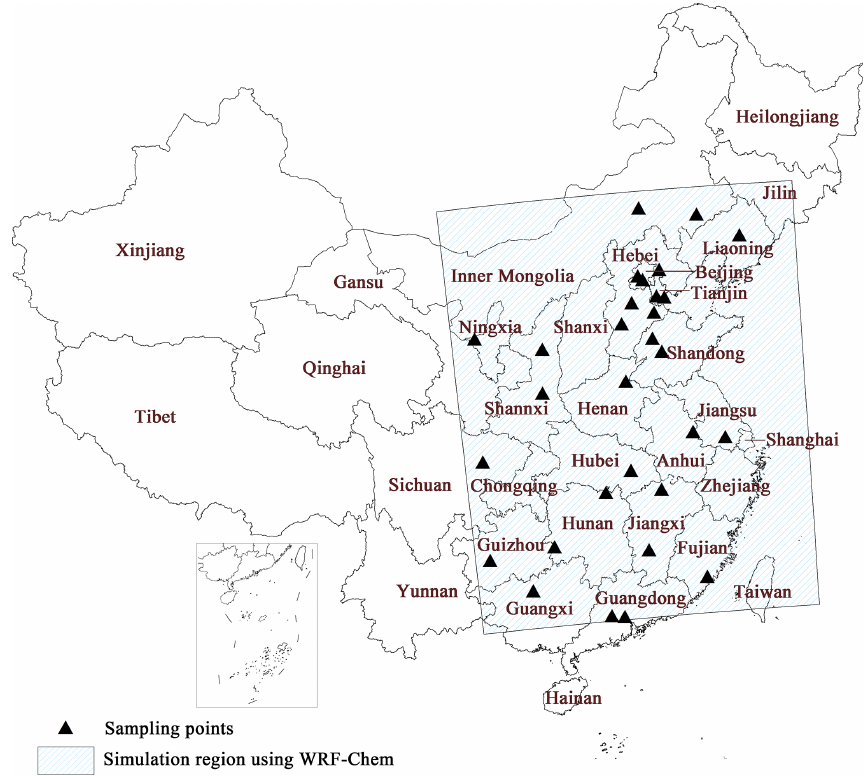
Figure 2. WRF-Chem simulation domain and sampling points (Ammonia Monitoring Network, China). Table 2. Comparison of estimated NH 3 emissions with those obtained in other studies. Source Base